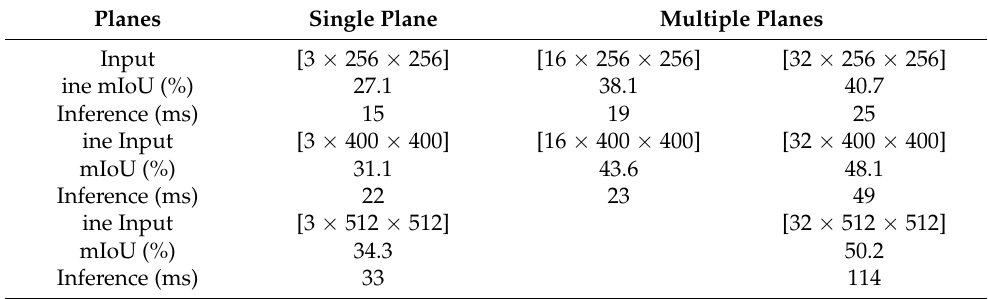
Table 2. Bird’s-eye projection results. Single plane projections use the maximum height, the corre- sponding intensity value, as well as the amount of points within each cell.